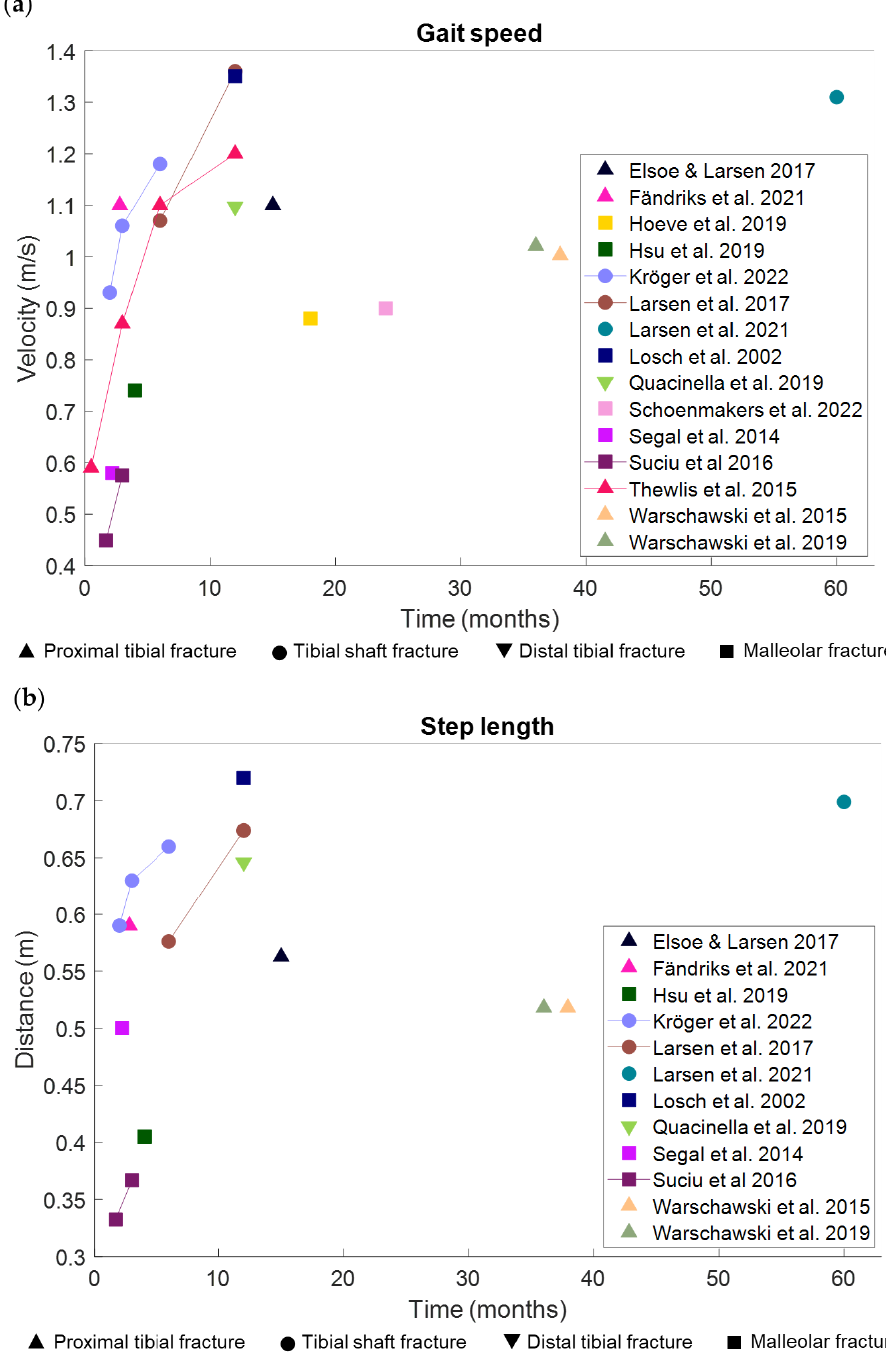
Figure 2. Overview of data from studies with different type of lower leg fractures [7,8,29–31,35,37–39,42–46,48]. ( a ) Gait speed after a lower leg fracture. ( b ). Step length after a lower leg fracture of the injured side. The type of lower leg fracture is indicated by the shape of the marker.